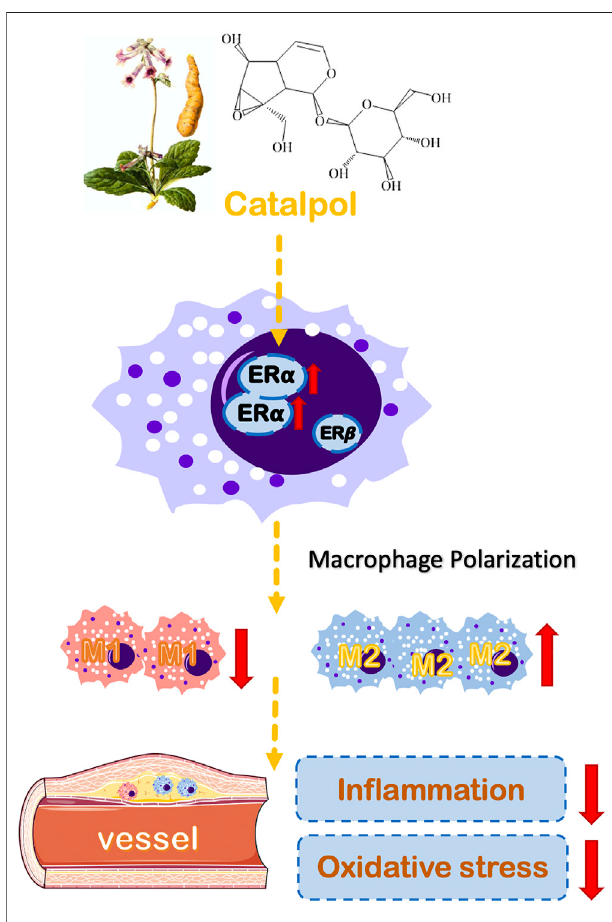
FIGURE 10 | A schematic diagram describing the protective mechanisms of catalpol against macrophages polarization and postmenopausal AS through ER α